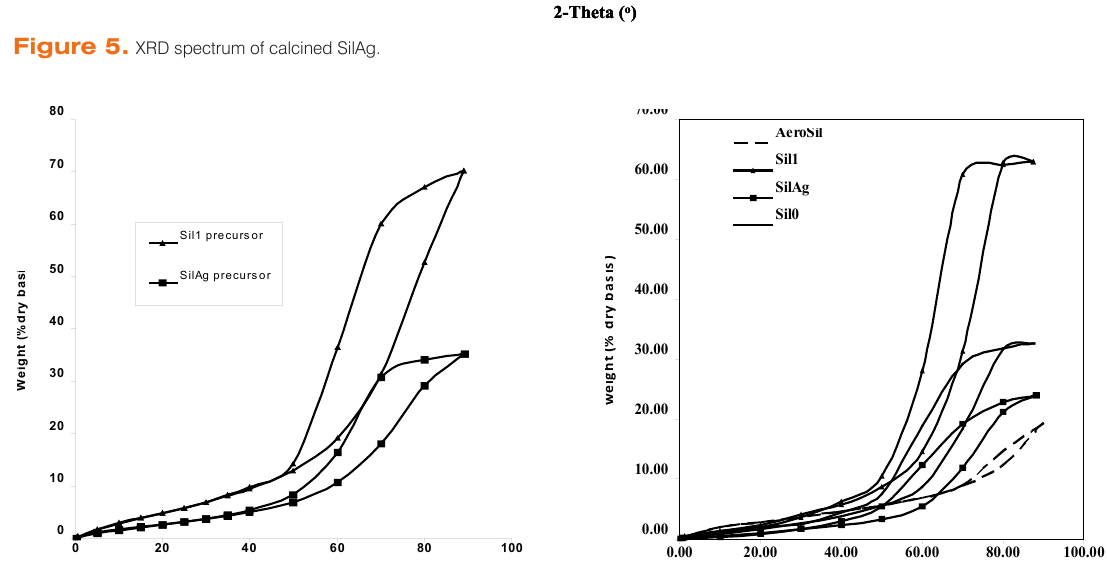
Figure 5. XRD spectrum of calcined SilAg.